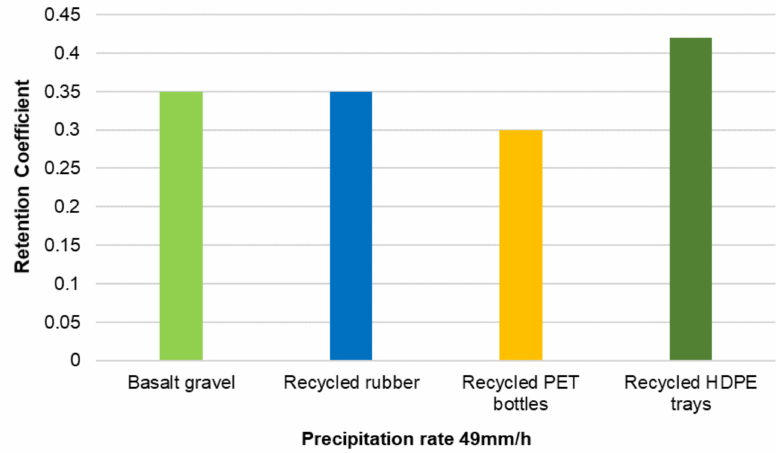
Figure 7. Average behavior of the retention coe ffi cient for intense rain condition between post-drought and stable